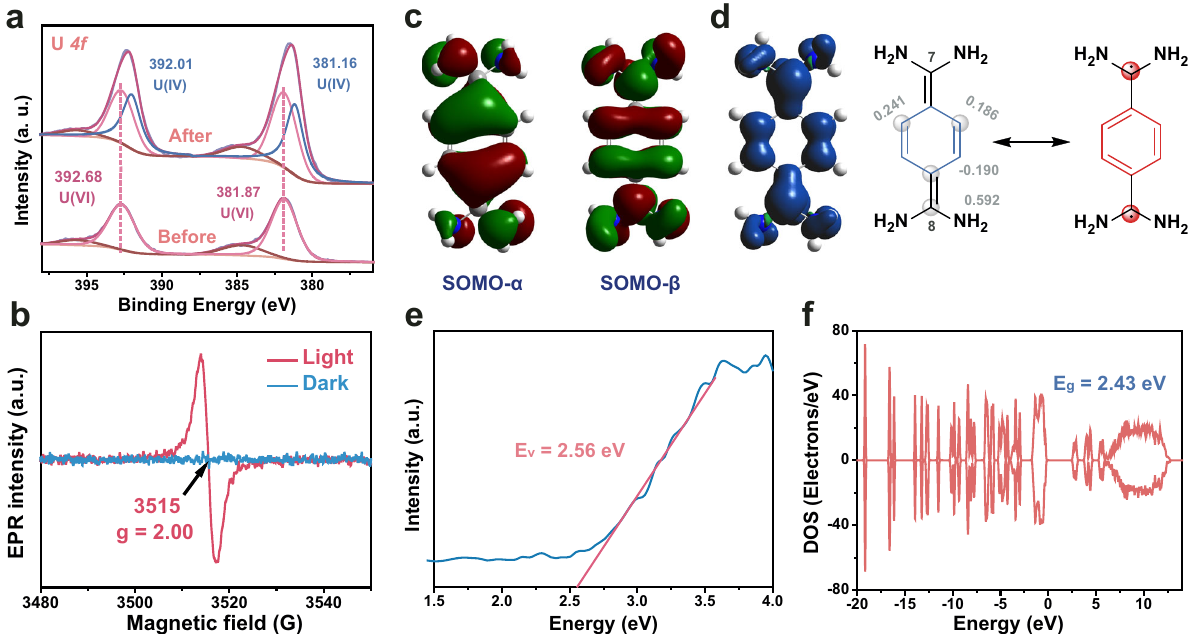
Fig. 4 Mechanism for the photoreduction of U(VI). a High-resolution XPS spectra of U before and after photoreduction. b EPR spectra of XHOF-TAQ in the dark and under light irradiation. c Calculated SOMOs for the α and β spin pro fi les of XHOF-TAQ. d Calculated spin density distribution of XHOF-TAQ. e The valence band XPS for XHOF-TAQ. f Calculated density of electronic states for